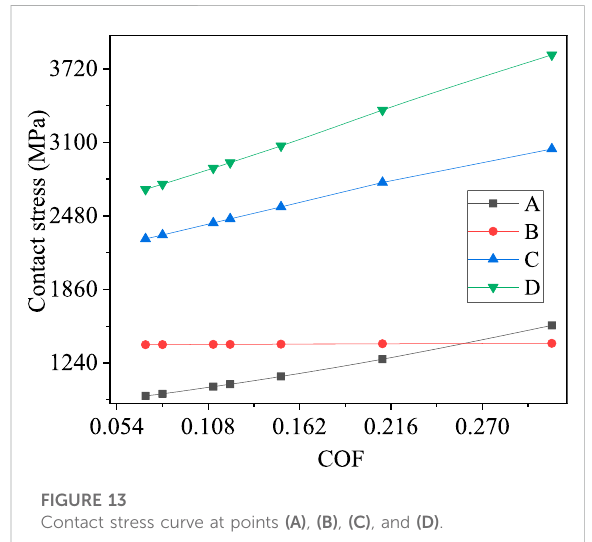
FIGURE 13 Contact stress curve at points (A) , (B) , (C) , and (D) .